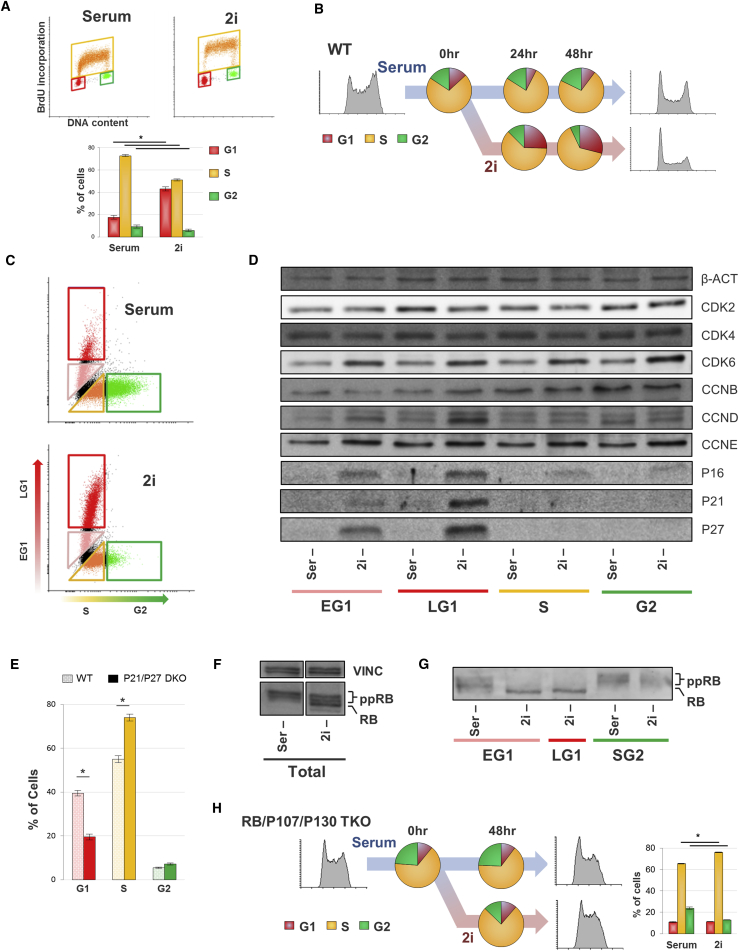
G1-Phase Is Elongated upon Adaptation of ESCs to 2i ConditionsFor a Figure360 author presentation of Figure 1, see the figure legend at http://dx.doi.org/10.1016/j.stem.2017.09.004.(A) DNA staining using PI in combination with BrdU incorporation shows a higher number of 2i R1 ESCs residing in G1 phase when compared to serum R1 ESCs. Significance was tested using the two-tailed Student’s t test; ∗p < 0.05.(B) Cell-cycle analysis using BrdU/PI shows that the rapid increase in the number of cells residing in G1-phase upon transition from serum to 2i occurs within 48 hr. Similar results were observed in several different male and female ESC lines.(C) FUCCI reporter expression shows that 2i ESCs reside longer in G1 phase, whereas the combined S-/G2-phase is shortened in 2i ESCs compared to serum ESCs. Indicated are the gates as used for sorting.(D) Western blot analysis of cell-cycle proteins involved in progression into S-phase in serum and 2i ESCs showing specific upregulation of the CDK inhibitors in 2i ESCs during both early and late G1-phase (EG1 and LG1, respectively). Three independent experiments showed similar results.(E) Distribution of cells over different phases of the cell cycle as determined by BrdU/PI staining performed in triplicate, using three independent P21/P27 DKO clones. A two-tailed Student’s t test was used to determine significance; ∗p < 0.05.(F) Western blot analysis of total cell populations showing only phosphorylated RB in serum ESCs. Western blot is representative of three independent experiments.(G) As in (C), using sorted early- and late-G1-phase as well as S-/G2-phase of ESCs, showing hypo-phosphorylated RB in G1-phase and phosphorylated RB (phospho-RB) in S-/G2-phase in 2i ESCs. At least two independent experiments showed similar results.(H) Cell-cycle analysis on RB/P107/P130 TKO ESCs using BrdU in combination with PI, showing an unaltered number of cells in G1-phase upon adaptation from serum to 2i. A decrease in the number of cells in G2-phase was observed. Results are representative of at least two independent experiments (∗p < 0.05, two-tailed Student’s t test).All values and error bars represent the mean ± SD. See also Figures S1 and S2 and Table S1.Figure360: An Author Presentation of Figure 1